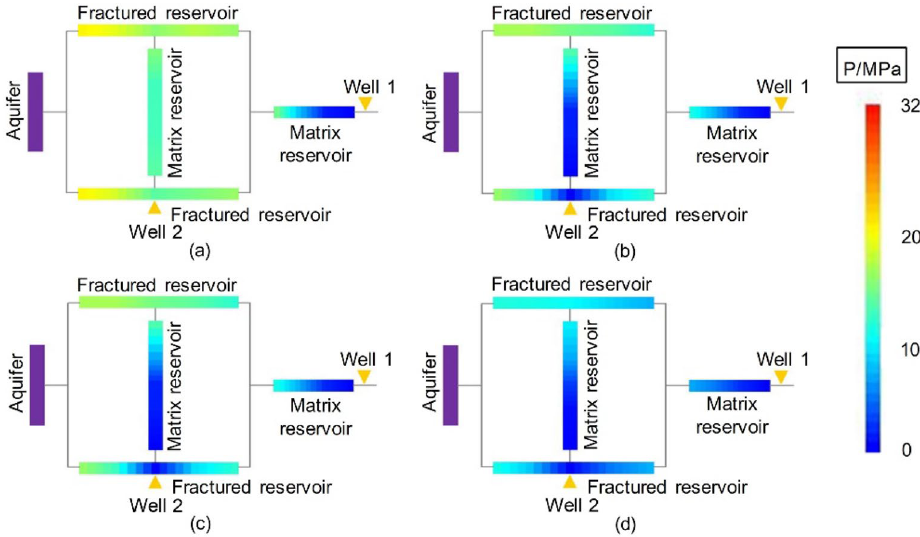
Figure 18. Pressure distributions at different times in the second stage of Experiment 3-1 (after drainage): ( a ) Well 2 started up—5 min, ( b ) end of the stabilized period of Well 2–14 min, ( c ) late production period—40 min, and ( d ) gas well production halted—184